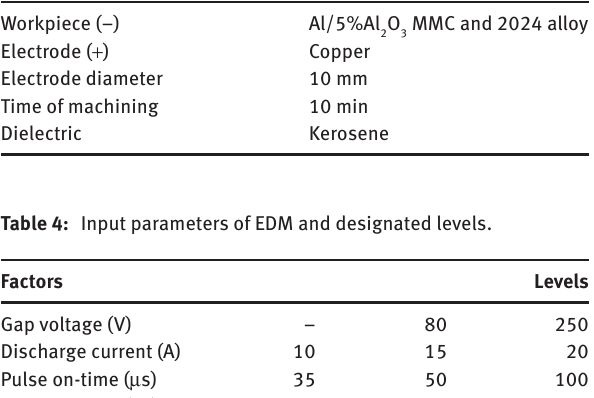
Table 3: Machining conditions and machine tool settings. Parameters